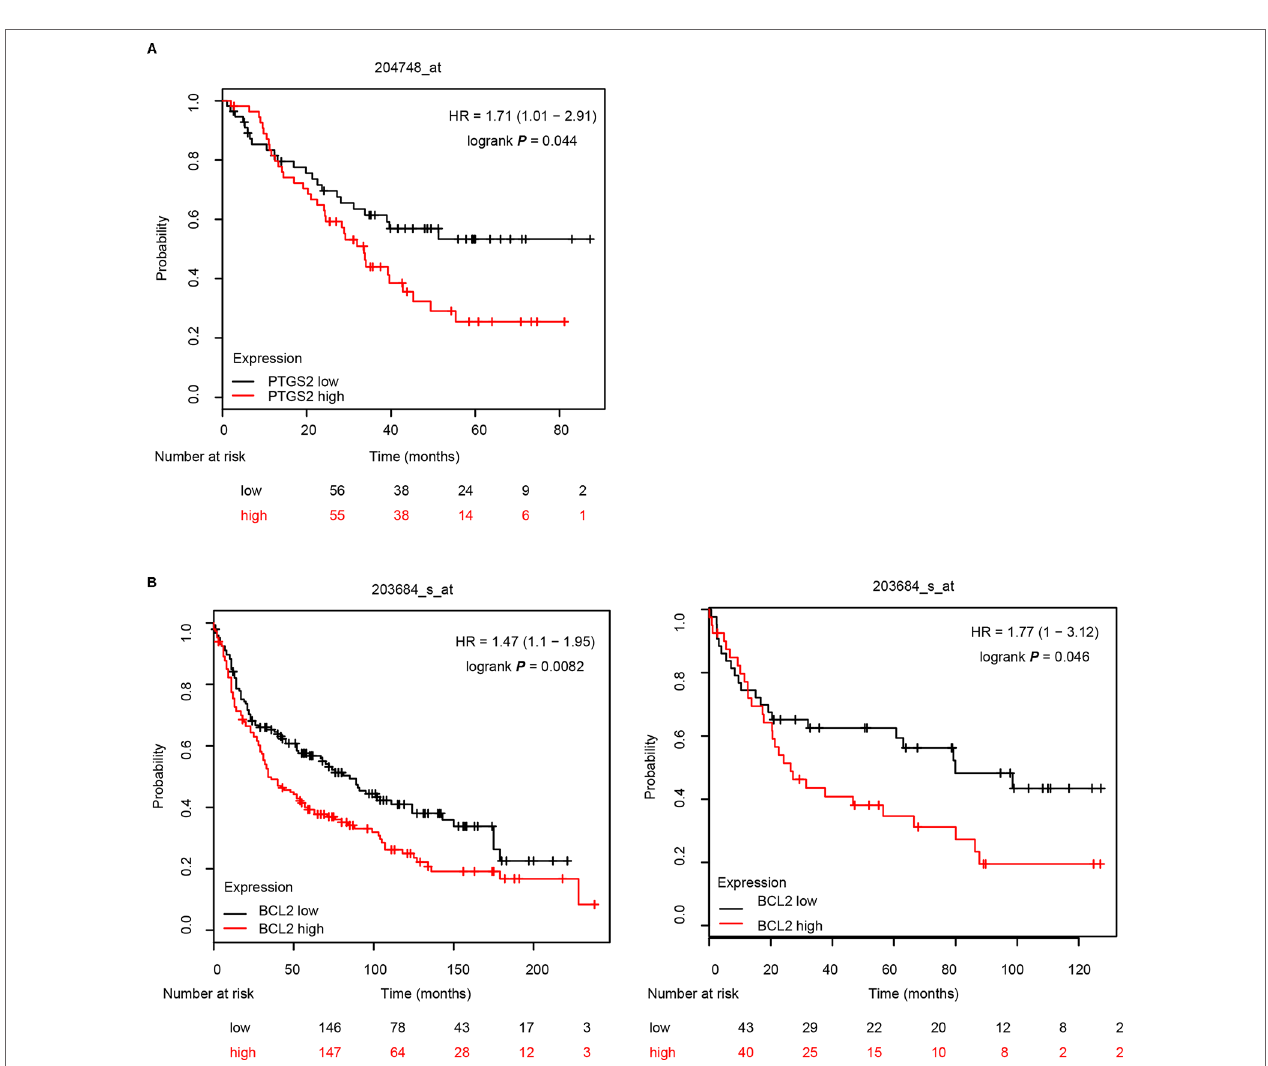
FIGURE 7 | PTGS2 and BCL2 predicted poor survival in NSCLC patients. The relationship between the expression levels of PTGS2 (A) and BCL2 (B) and the life period was analyzed in the Kaplan–Meier plotter website